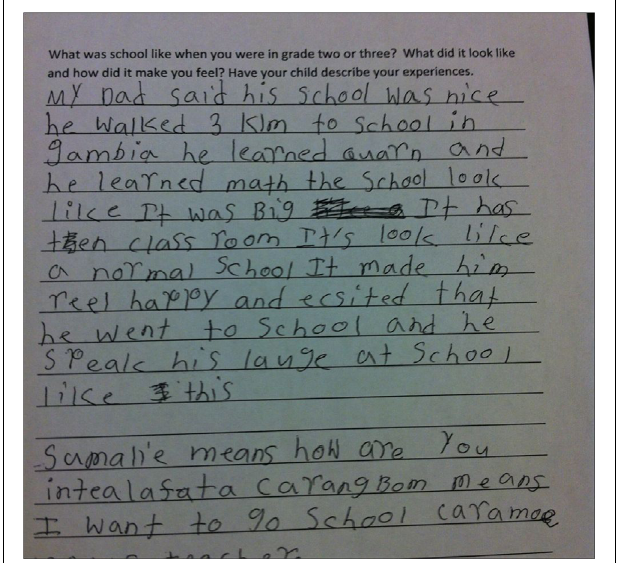
FIGURE 3 | Fatu’s first